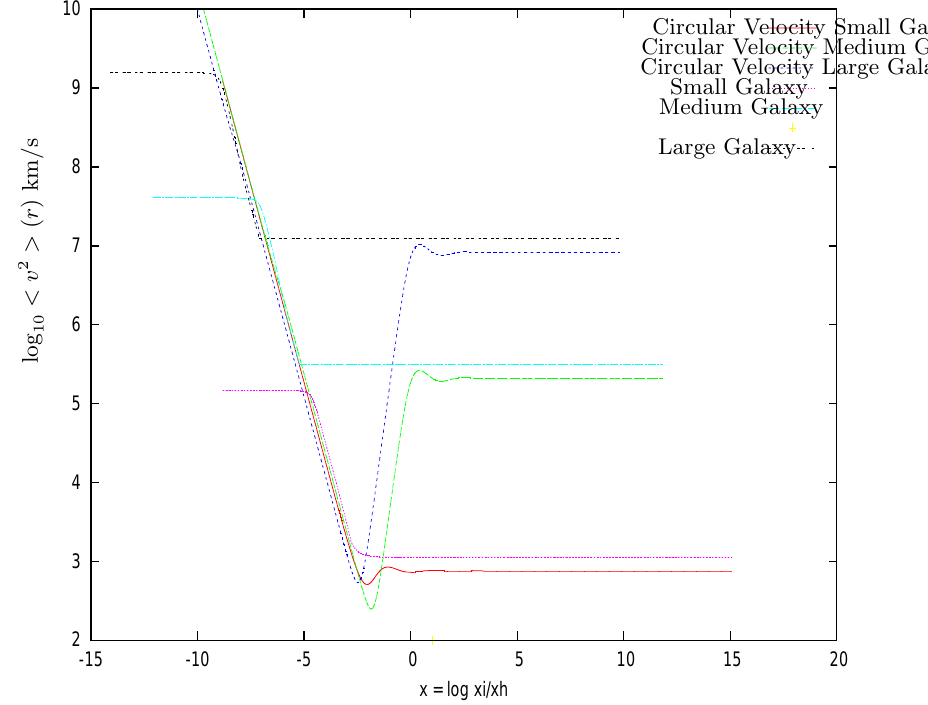
for fixed values of ξ 0 .